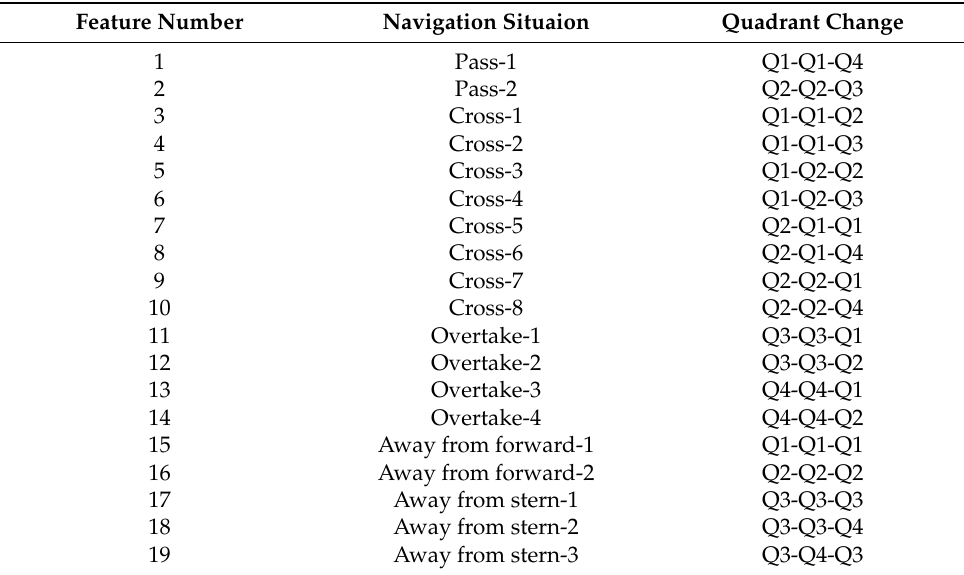
Table 3. Feature